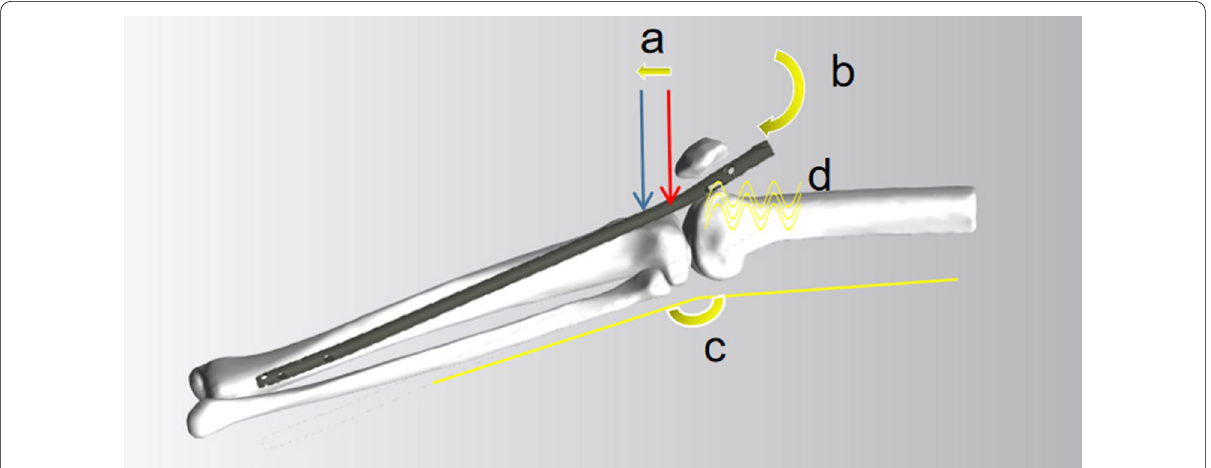
Fig. 1 The primary unique elements of the SEIP technique include the following: a shows a more distal tibial entry point (the red arrow represents a traditional HFIP entry point while the blue arrow represents a SEIP entry point); b represents modern IMN designs, including suitable Herzog curvature on the proximal side, curvature on the distal side, and a short proximal jig; c shows an extra‑articular approach with the knees flexed about 30°; and d indicates the use of a protective soft pad on the femoral side. SEIP semi‑extended infrapatellar, HFIP hyperflexed infrapatellar